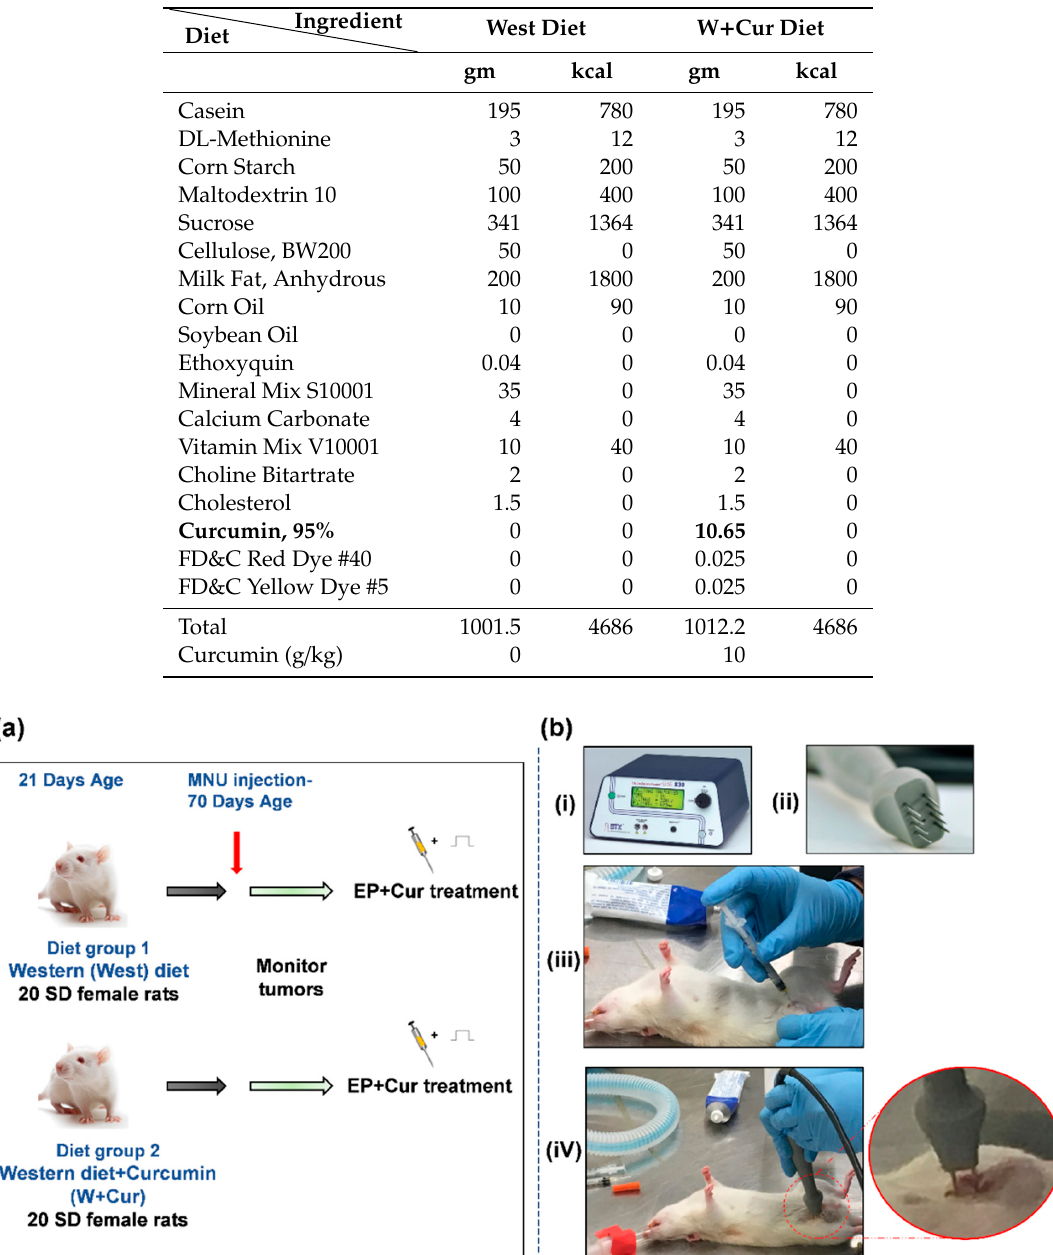
Table 1. The ingredients of western (West) diet and western diet supplemented with 1% w / w curcumin (W + Cur).